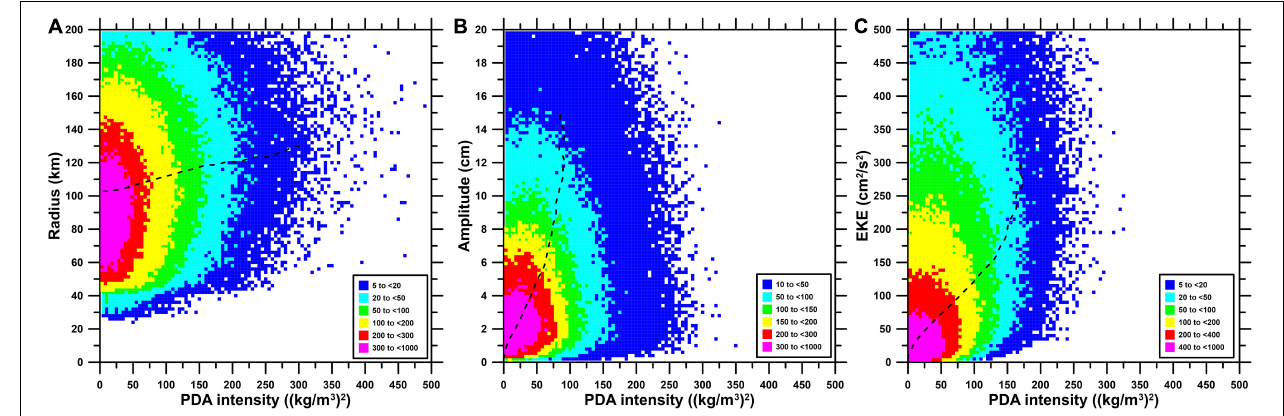
FIGURE 9 | Scatter diagrams of eddy property versus potential density anomaly intensity during 2002–2019. (A) Radius, (B) amplitude, and (C) eddy kinetic energy (EKE). The color bars denote eddy numbers. The black dashed curves depict the most likelihood of eddy properties with respect to potential density anomaly